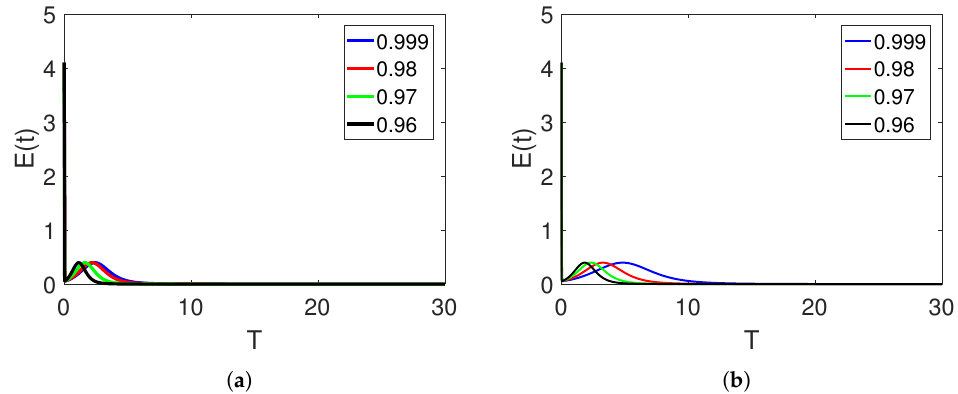
Figure 14. Comparison of Newton polynomial ( a ) and LADM ( b ) for second class on different arbitrary fractional order.